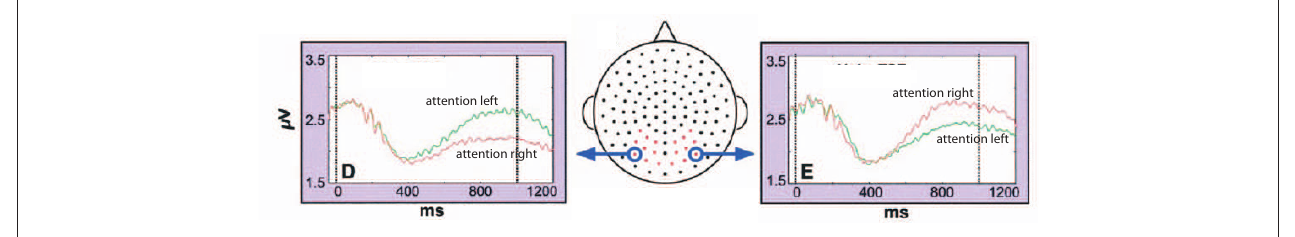
Figure 3 | Hemispheric alpha lateralization in response to left or right covert attention. This effect has later been tested as a control signal for BCI. When subjects were asked to attend to the right, left hemisphere alpha was